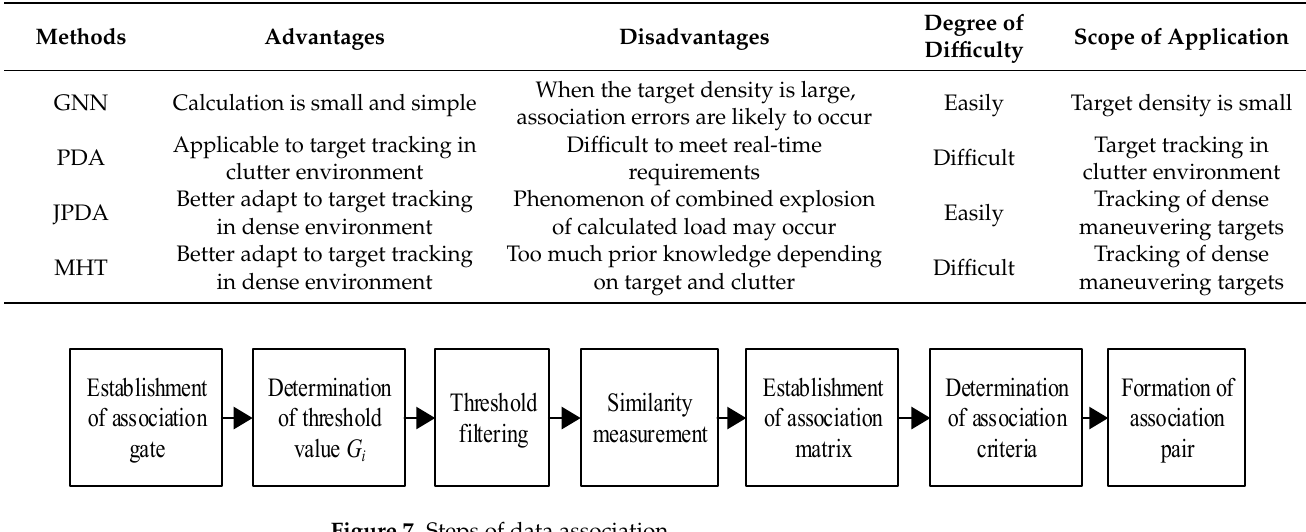
The purpose is to remove some observations that are far from the target, and to match only those within the association gate, which can reduce the computation of the subsequent association. The established association gate (Figure 8) integrated the longitudinal distance measurement error of the mmWave radar with the lateral distance measurement error of the camera.